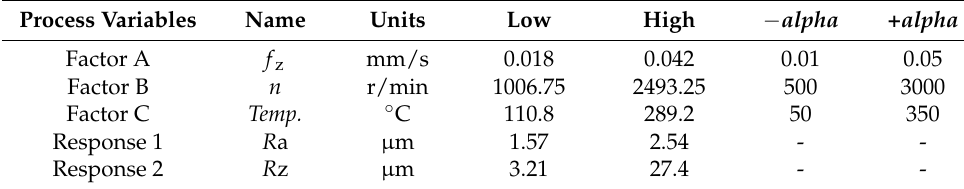
Table 2. Table of process variables and their bounds. Process Variables